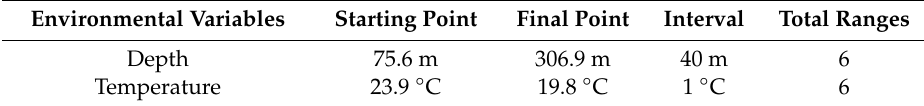
Table 1. Ranges (means) of depth and temperature of wahoo with “intervals” of observation. Environmental Variables Statistics of the number of fish (N ij , N ij ) and hooks (H ij , H ij ） at different layer ranges and temperature variables.